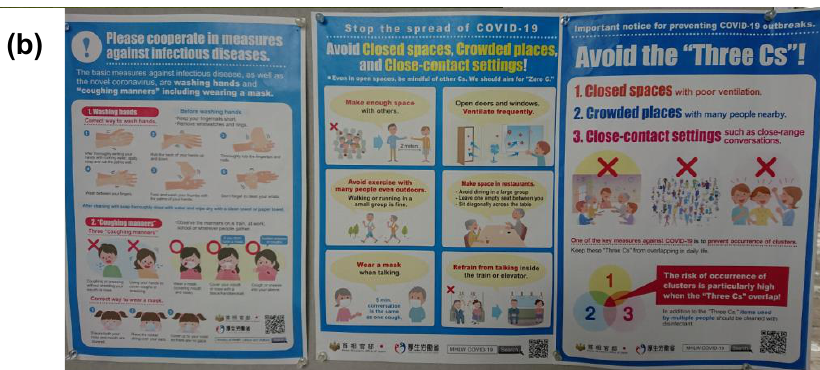
Figure 1. ( a ) A banner reminding park goers to keep a social distance of 2 m. ( b ) Posters on a public notice board showing the preventive measures recommended by Japan Ministry of Health, Labour